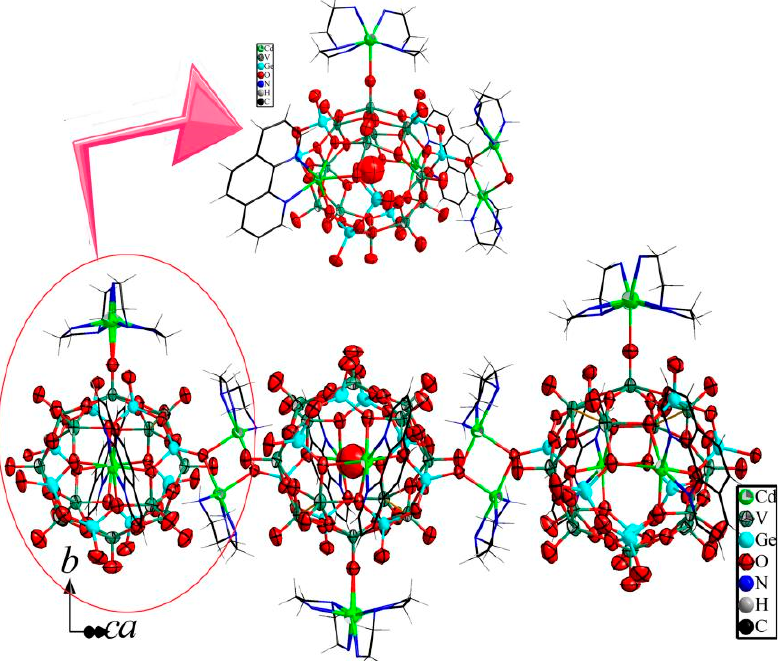
Figure 2. Ball-and-stick and wire representation of the building unit in the 1-D chain structure ( upper ) and the 1-D chain structure formed by Ge-V-O clusters and [Cd 2 (DETA) 2 O 2 ] ( lower ).